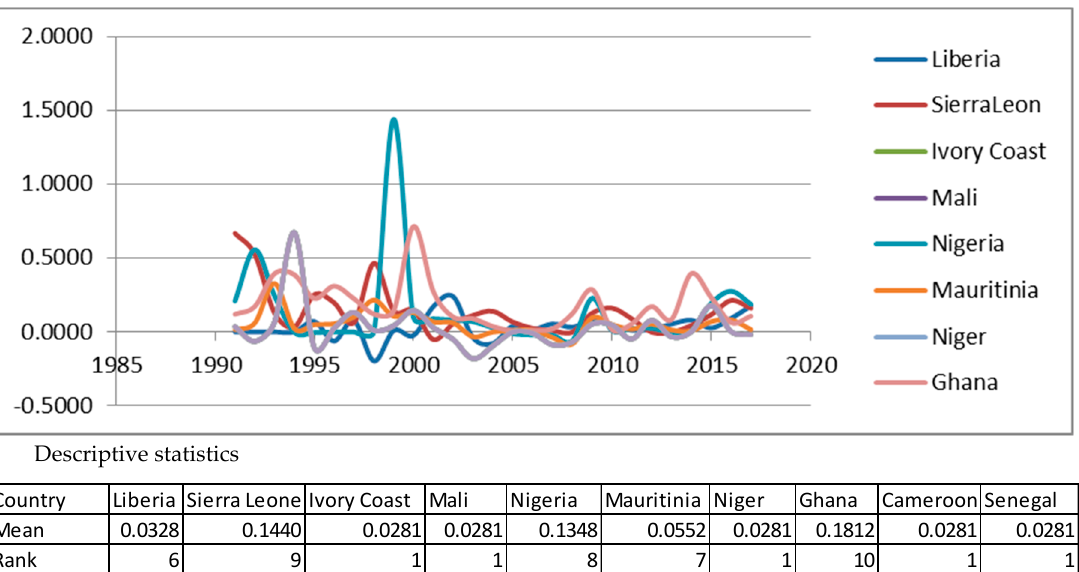
Figure A3. Exchange Rate changes year to year% (1990–2017).